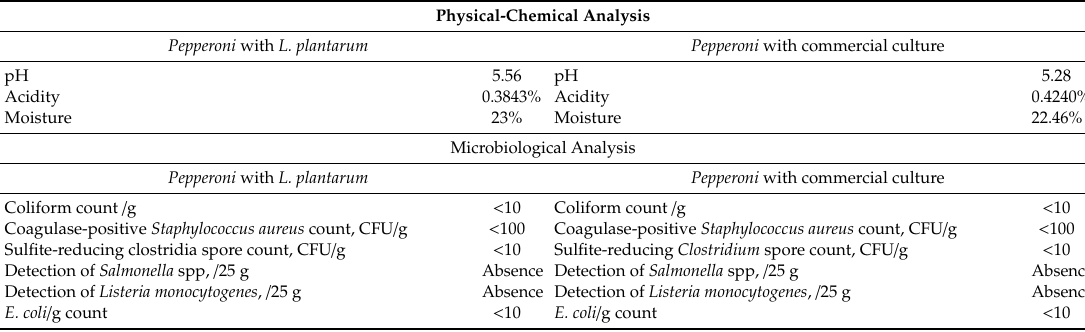
Table 5. Physical-chemical and microbiological parameters of pepperoni with L. plantarum and control with commercial